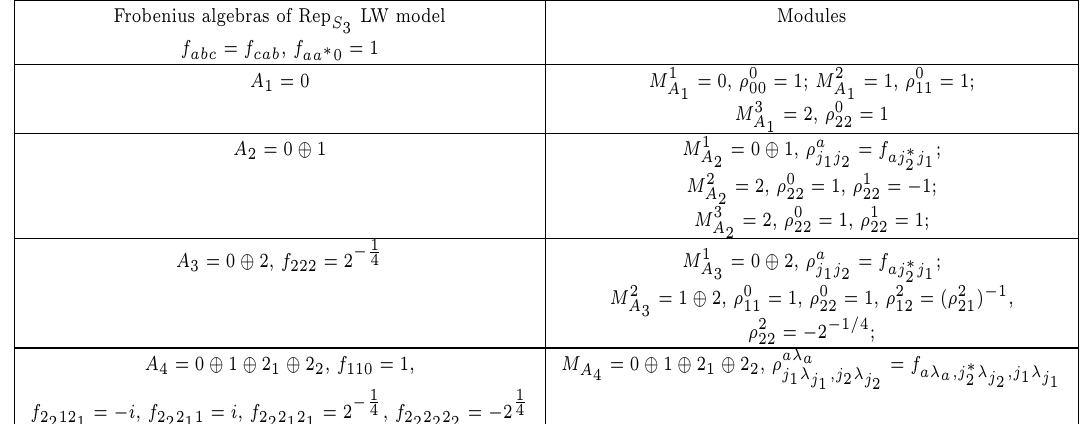
Table 8 . Modules of the Frobenius algebra objects in Rep